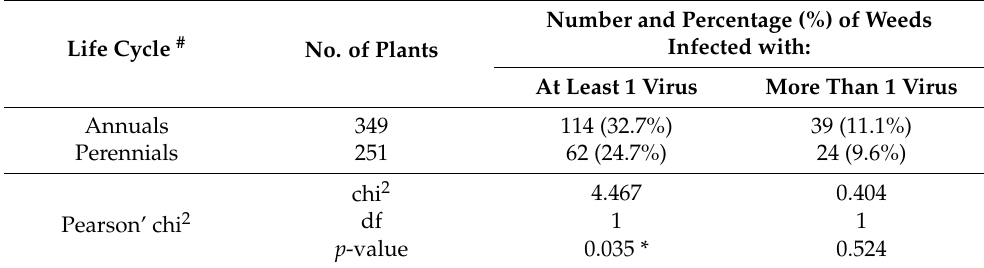
Number and Percentage (%) of Weeds Infected